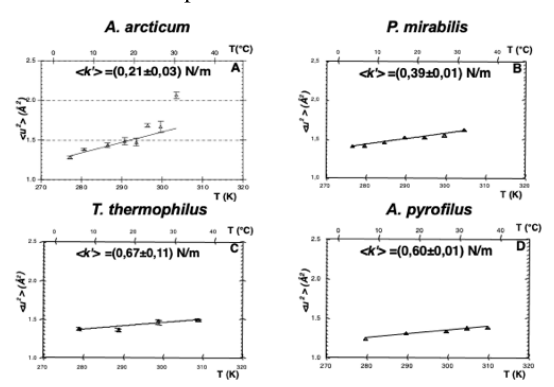
Fig. 4. From [20]. Elastic window temperature scans of Aquaspirillum arcticum (a psychrophile, adapted to 4 ºC in glacial waters), Proteus mirabilis (a mesophile adapted to body temperature), Thermus thermophilus (a thermophile, adapted to 65 ºC) and a hyperthermophile, Aquifex pyrofilus (85